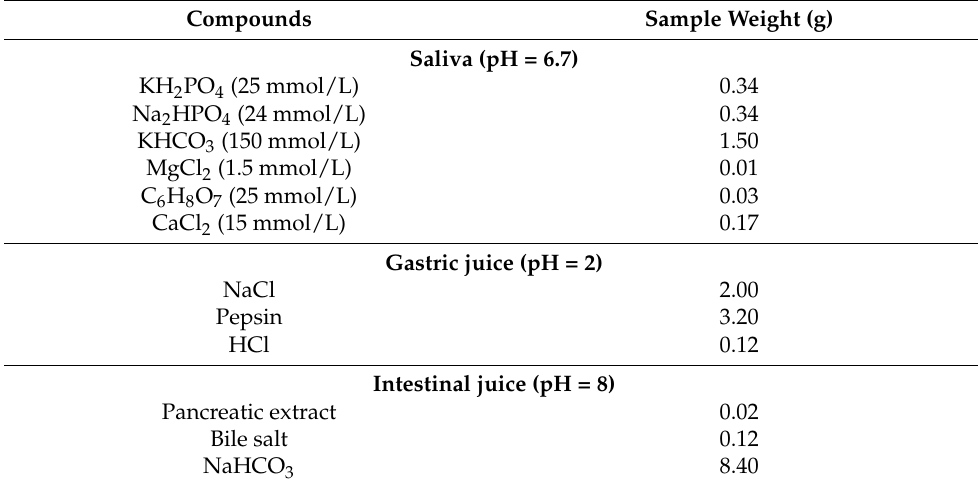
Table 1. Composition of artificial digestive juices